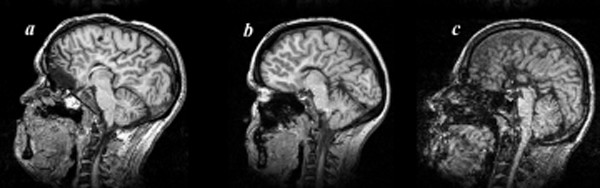
MRI images of patients in the sagittal plane. MRI image showing complete agenesis of the corpus callosum and the preserved anterior commissure of (A) patient M.G. and (B) patient S.G., as well as complete agenesis of both the corpus callosum and the anterior commissure of (C) patient S.Pe.